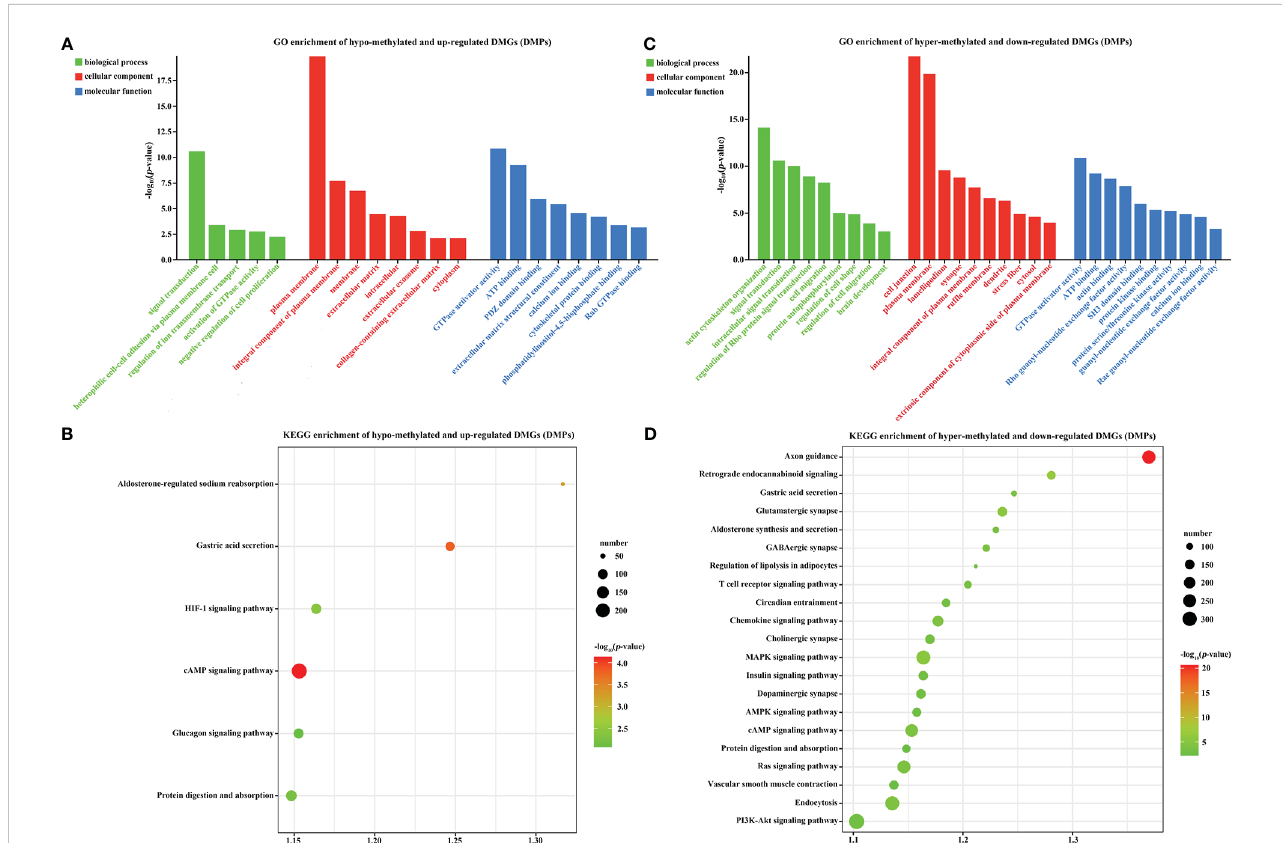
FIGURE 7 GO and KEGG analysis of DMR target genes in the gills of large yellow croaker under low-salinity stress. (A) GO enrichment of up-regulated, hypo- methylated DMGs; (B) KEGG pathway enrichment of up-regulated, hypo-methylated DMGs; (C) GO enrichment of down-regulated, hyper-methylated DMGs; (D) KEGG pathway enrichment of down-regulated, hyper-methylated